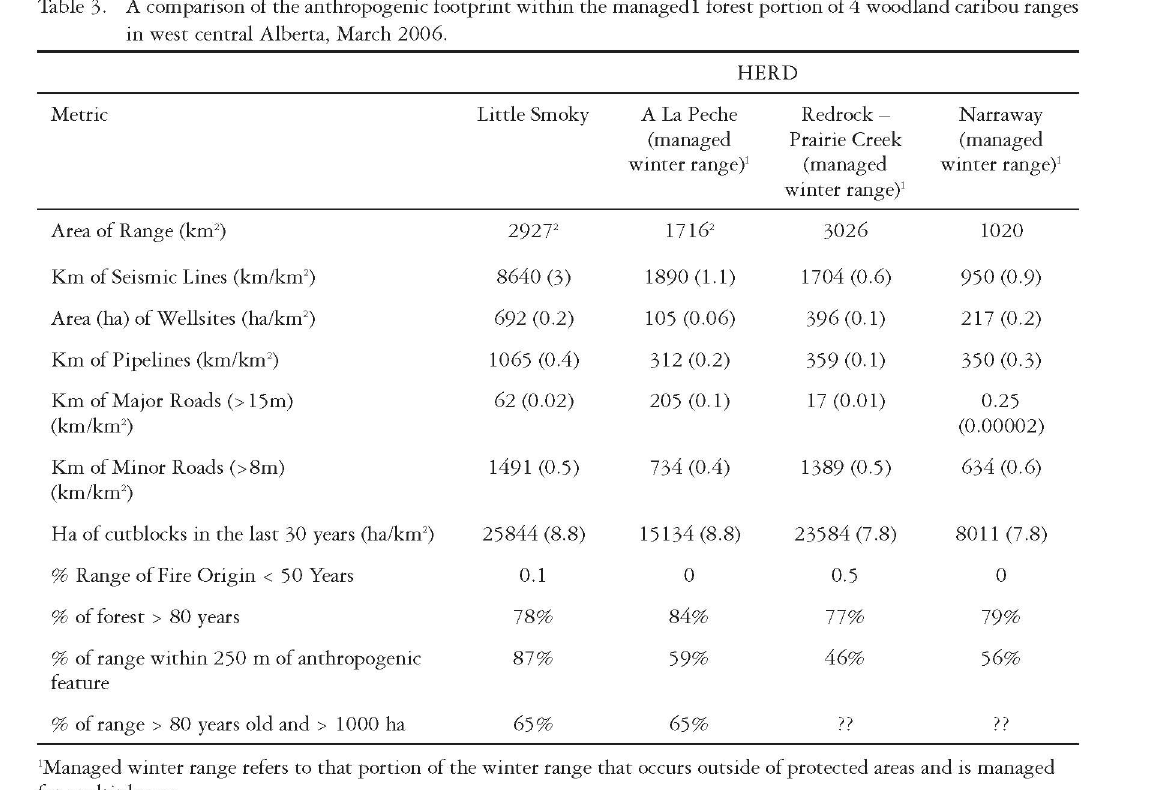
Table 3. A comparison of the anthropogenic footprint within the managed1 forest portion of 4 woodland caribou ranges in west central Alberta, March 2006.